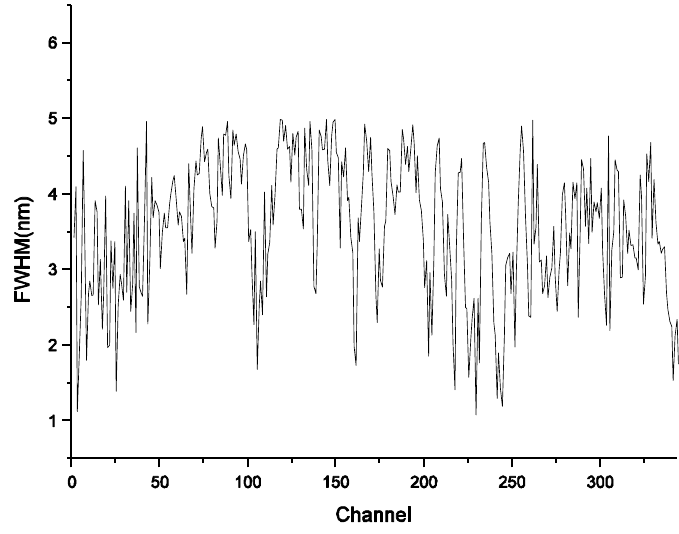
Figure 8. Spectral resolution for all 344 channels of the FISS system.